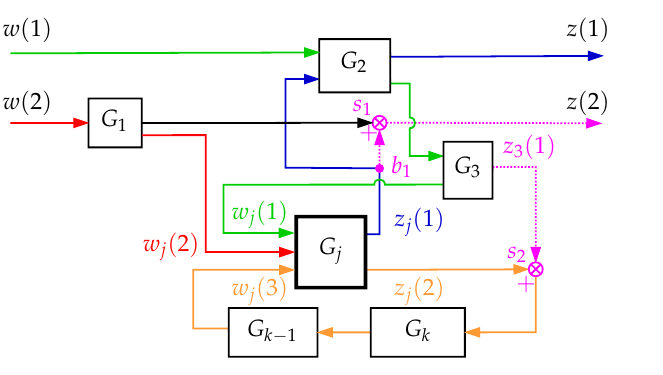
Figure 13. Example of the interconnected dissipative dynamical system. Defining the paths of energy transfer to and from the subsystem G j .